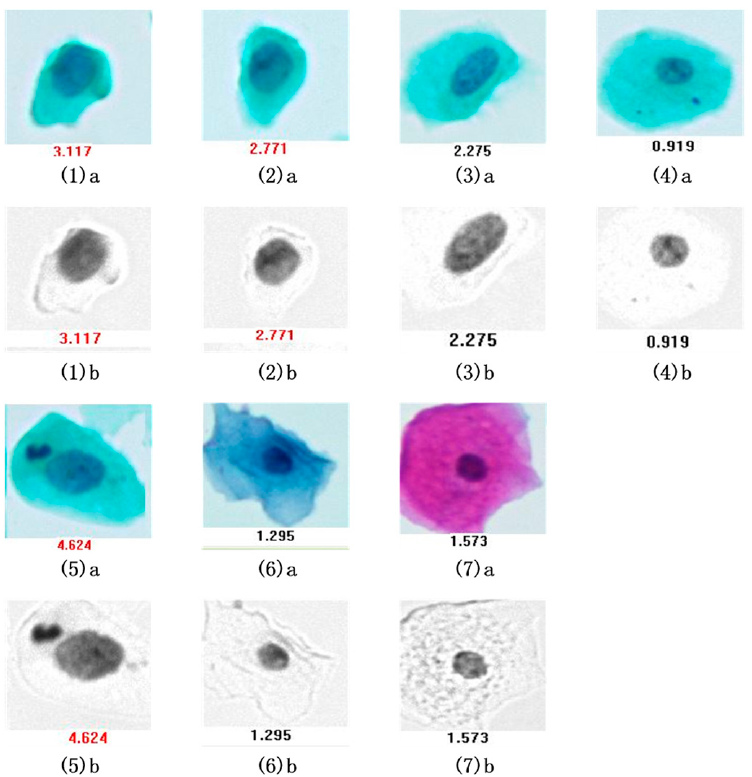
Figure 6. The microspectral images of DNA unmixing results; ( 1a – 7a ) the images of co-stained cytoplasms and nuclei, ( 1b – 7b ) the grayscale images of cell nuclei after absorbance unmixing.